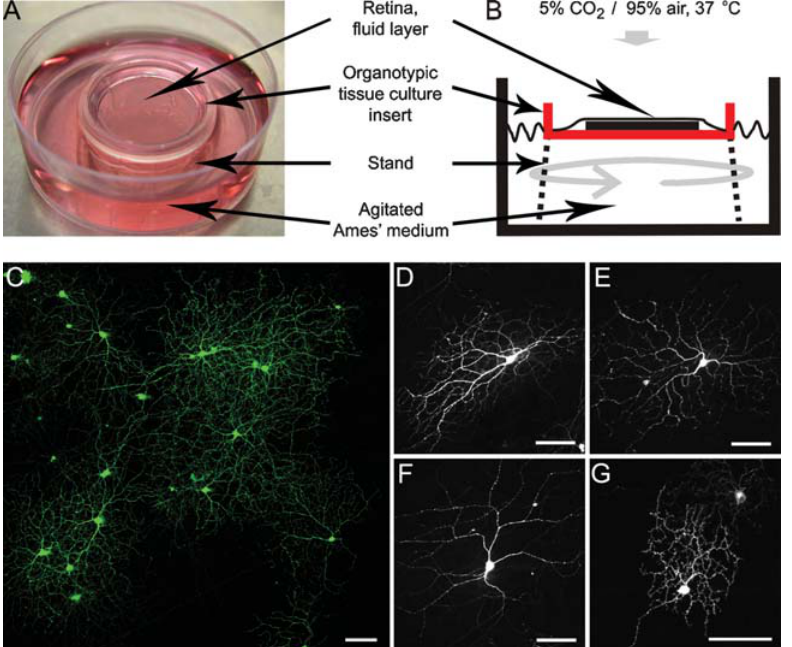
Figure 1. Incubation of rabbit retina. Photograph ( A ) and schematic diagram ( B ) of the hybrid interphase/perfusion chamber. Deep dishes are used with custom made ‘‘stands’’ of 1 cm height to support the tissue culture insert with the flat-mounted retina. The retina is in contact with the Ames’ medium over the filter on the photoreceptor side; the ganglion cell side faces the atmosphere. ( C ) Low power micrograph of adult rabbit retina transfected with an expression plasmid for EGFP after 4 days in culture. Scale bar, 100 m m. ( D ) ON/OFF Directionally selective ganglion cell (Type G7, bistratified). All panels show maximum intensity projections of , 20 individual image planes of a through-focus series taken at 1 m m steps on a confocal microscope. ( E ) ON directionally selective ganglion cell (G10). ( F ) Alpha cell. ( G ) Brisk sustained cell (G4). All scale bars, 100 m m.